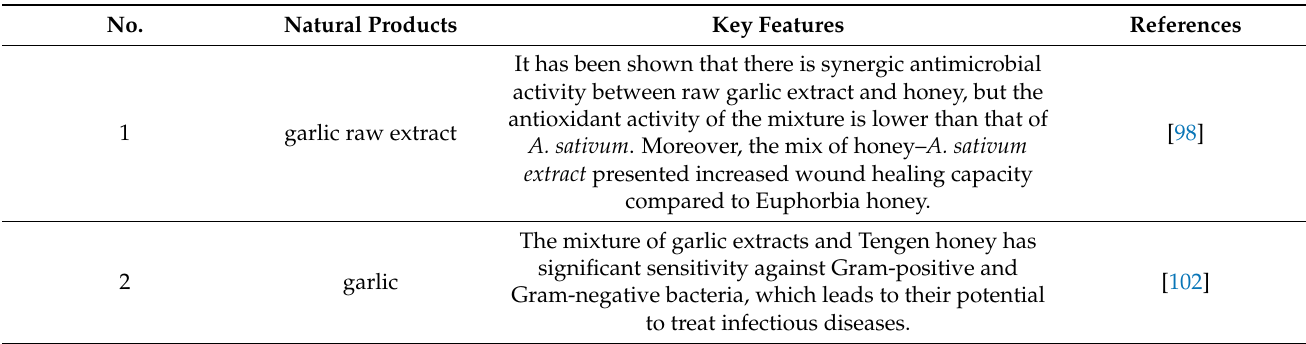
Table 2. Synergic effect of honey with other natural